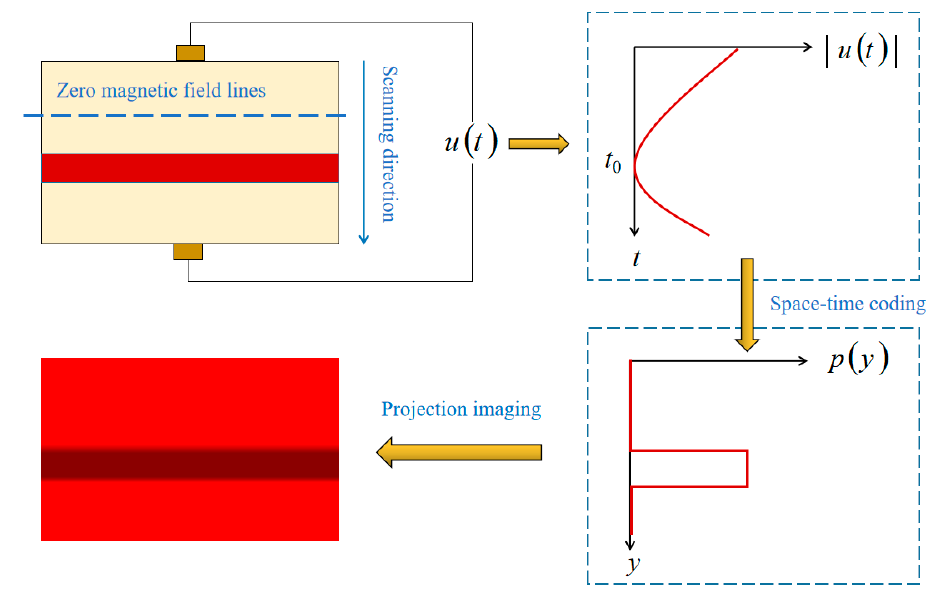
Figure 5. Schematic diagram of arterial profile scanning imaging based on a linear gradient magnetic field.